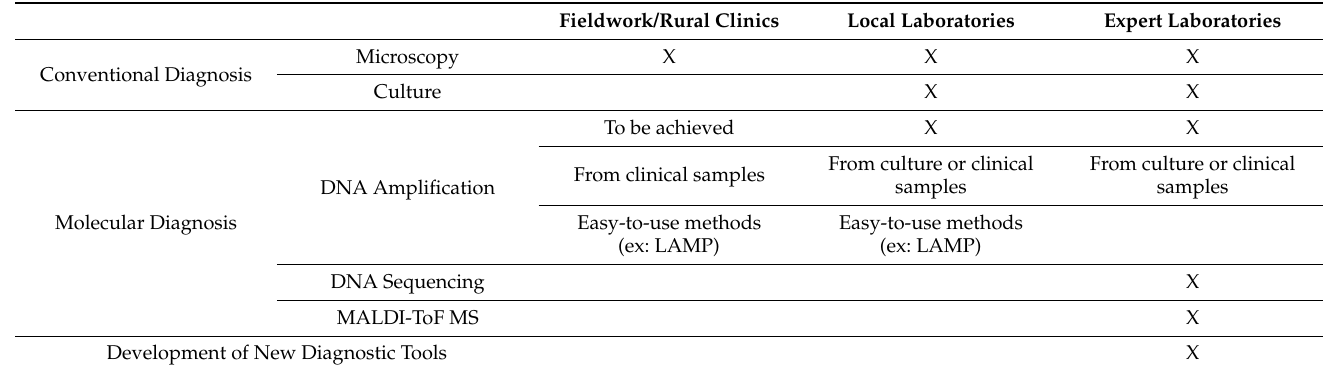
Table 1. Availability of molecular diagnostic techniques of chromoblastomycosis and